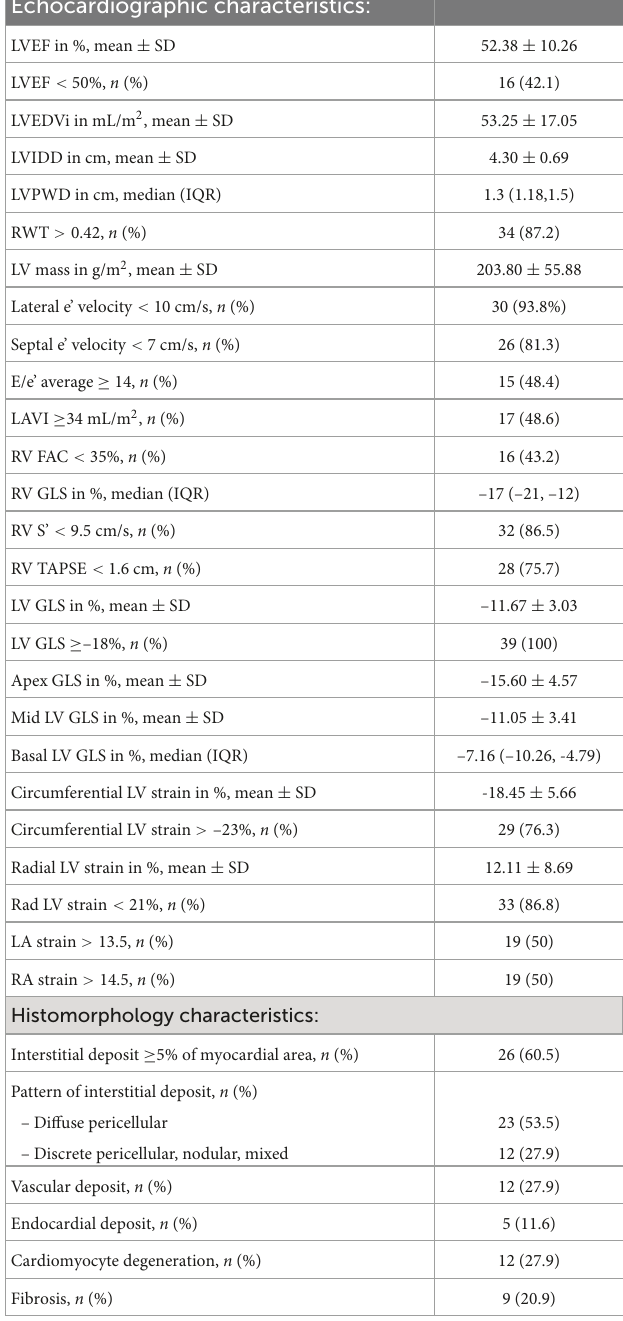
TABLE 2 Echocardiographic and histomorphology characteristics of 43 patients with endomyocardial biopsy-proven cardiac AL amyloidosis. Echocardiographic